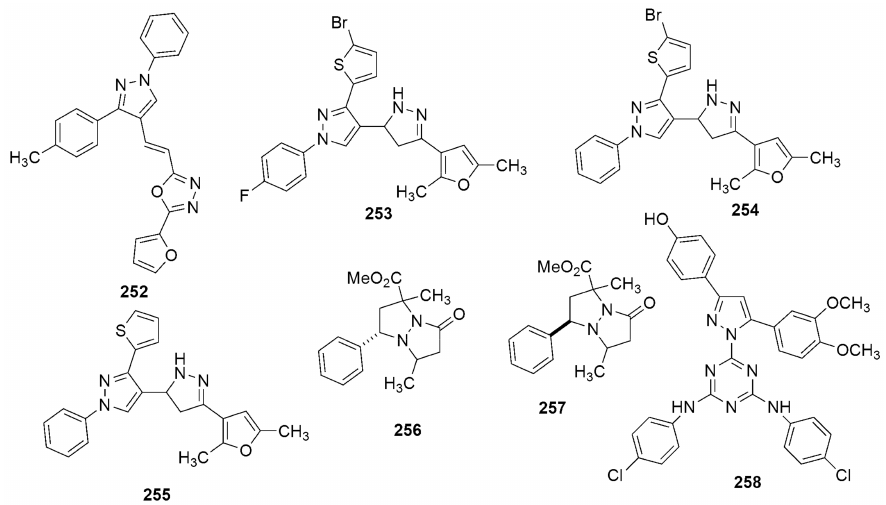
Figure 14. Structures of pyrazoles derivatives as potent antimalarial